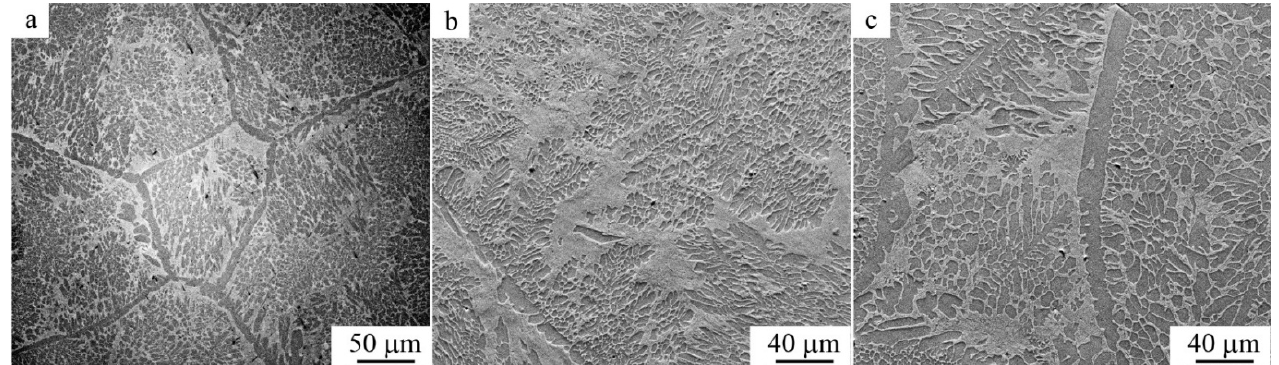
Figure 7. «Stress–strain» curves taken in tensile tests of the Cu-xAl-4.5Ni alloys (the modes of quenching, annealing and weight compositions are indicated). ( a – c ) Heating for quenching for 10 min (10’) and annealing for 60 min (60’).